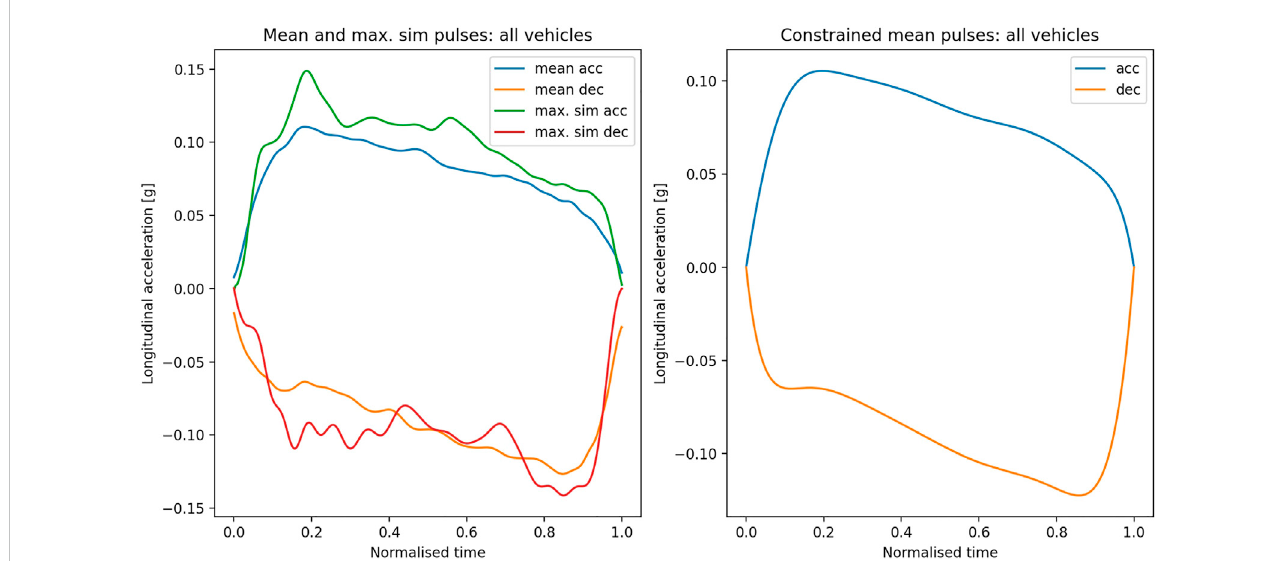
FIGURE 3 Average acceleration and deceleration pulses. Left: computed according to the “ unconstrained mean pulse method ” (coef fi cients up to order N = 50) and the “ maximum similarity method. ” Right: computed according to “ constrained mean pulse method ” (coef fi cients up to N = 10). All vehicle types.